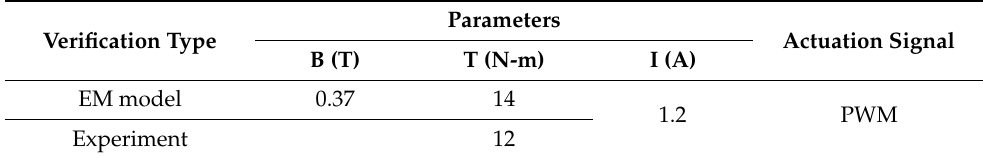
Table 2. Results of PWM actuation